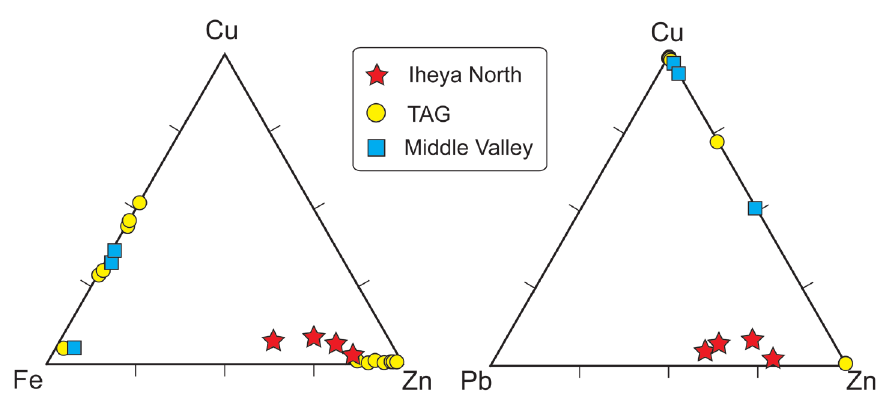
Figure 2. Ternary diagrams of the composition of sulfide samples from active hydrothermal fields. Iheya North data from Ueno et al. (2003). TAG = TAG mound, Mid-Atlantic Ridge, Middle Valley = Middle Valley, Juan de Fuca Ridge. Modified from Takai et al.